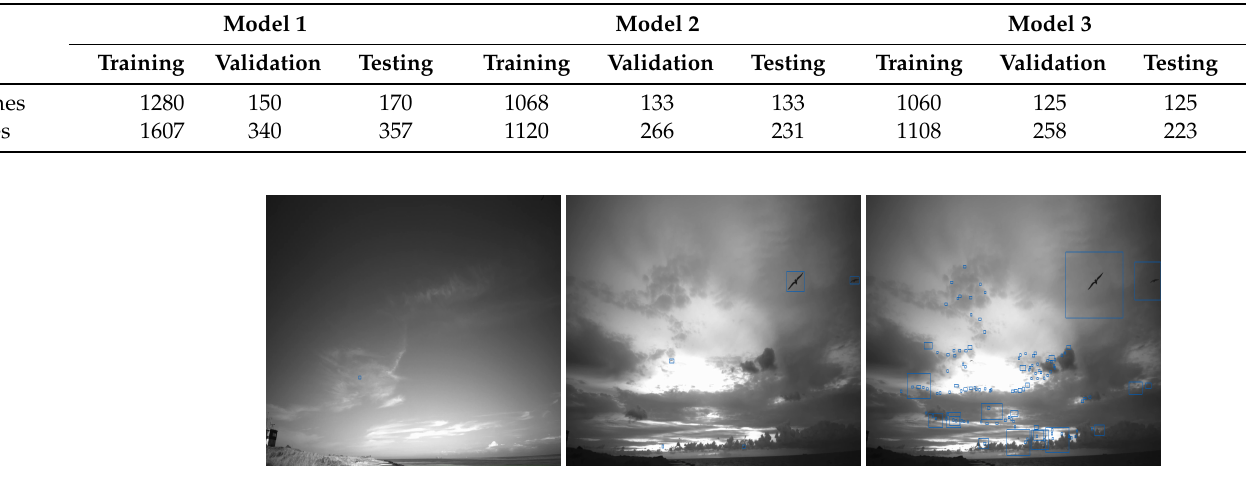
Figure 4. Background subtraction based model for bird detection. Bird detection on a frame from Skagen dataset ( left ). Ground truth bird bounding boxes on a frame from the Klim dataset ( middle ) and detection results exhibiting a large number of false positives ( right ).